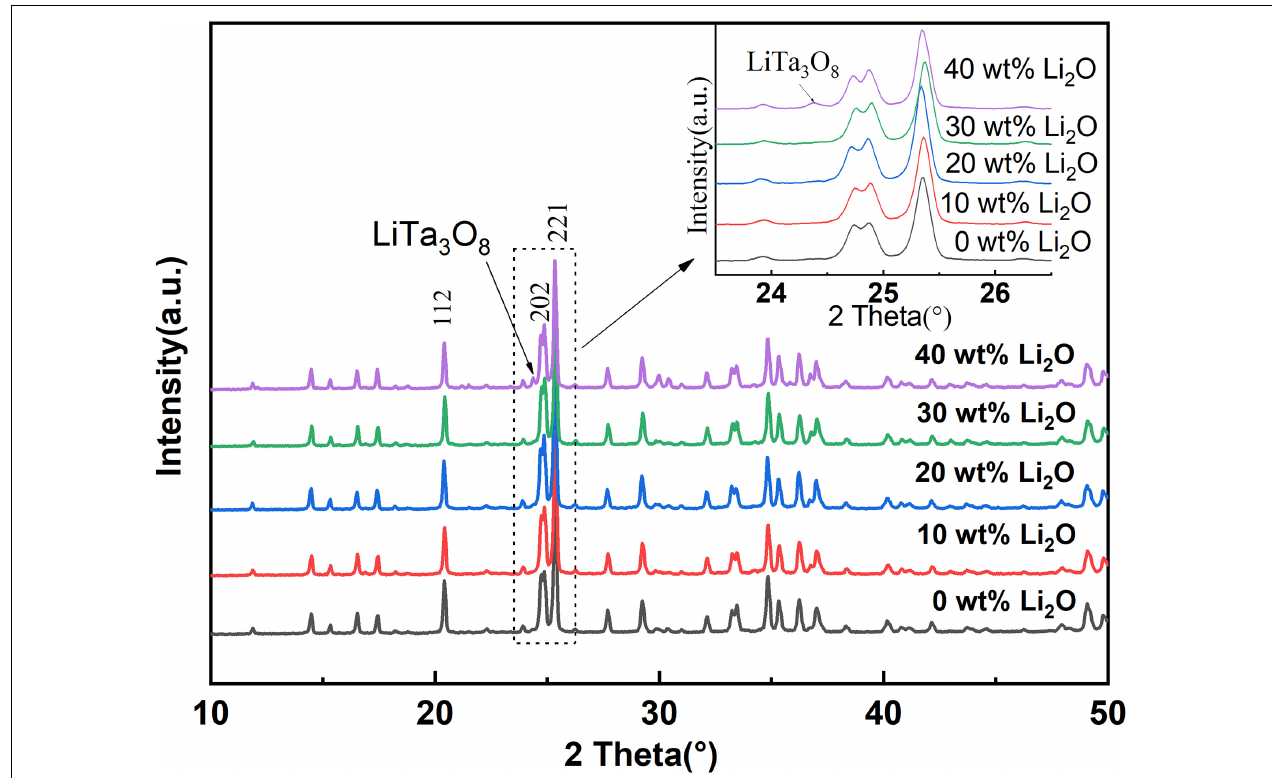
FIGURE 1 | Powder XRD patterns of LTPO prepared with different excess lithium addition amount sintered at 1050 ◦ C for 12 h.